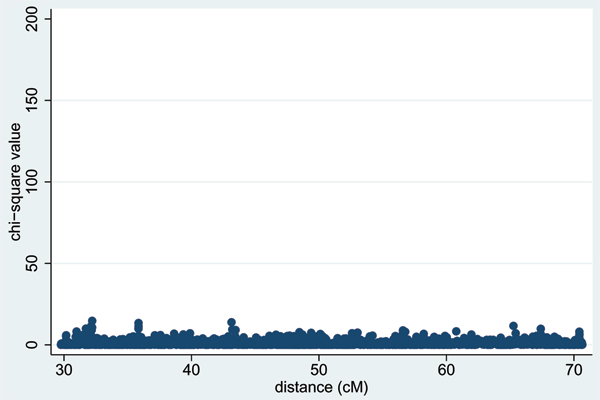
Residual association after stepwise regression. Results are shown after accounting for SNPS 3437, 3439 and 3931 (Replicate 1).